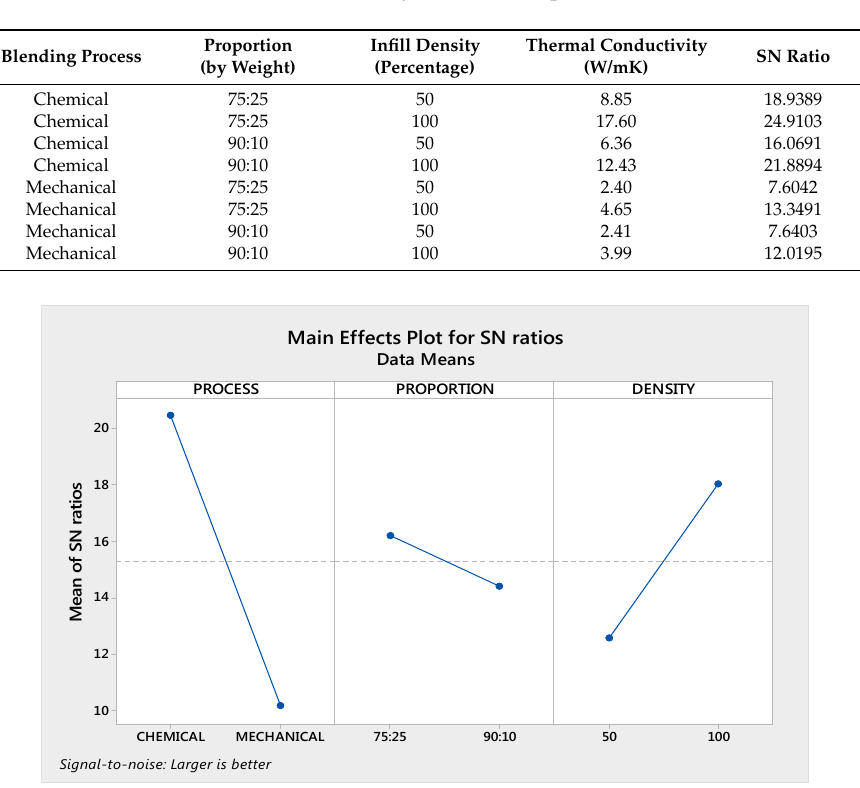
Table 7. Thermal conductivity of tested sample with SN ratios.